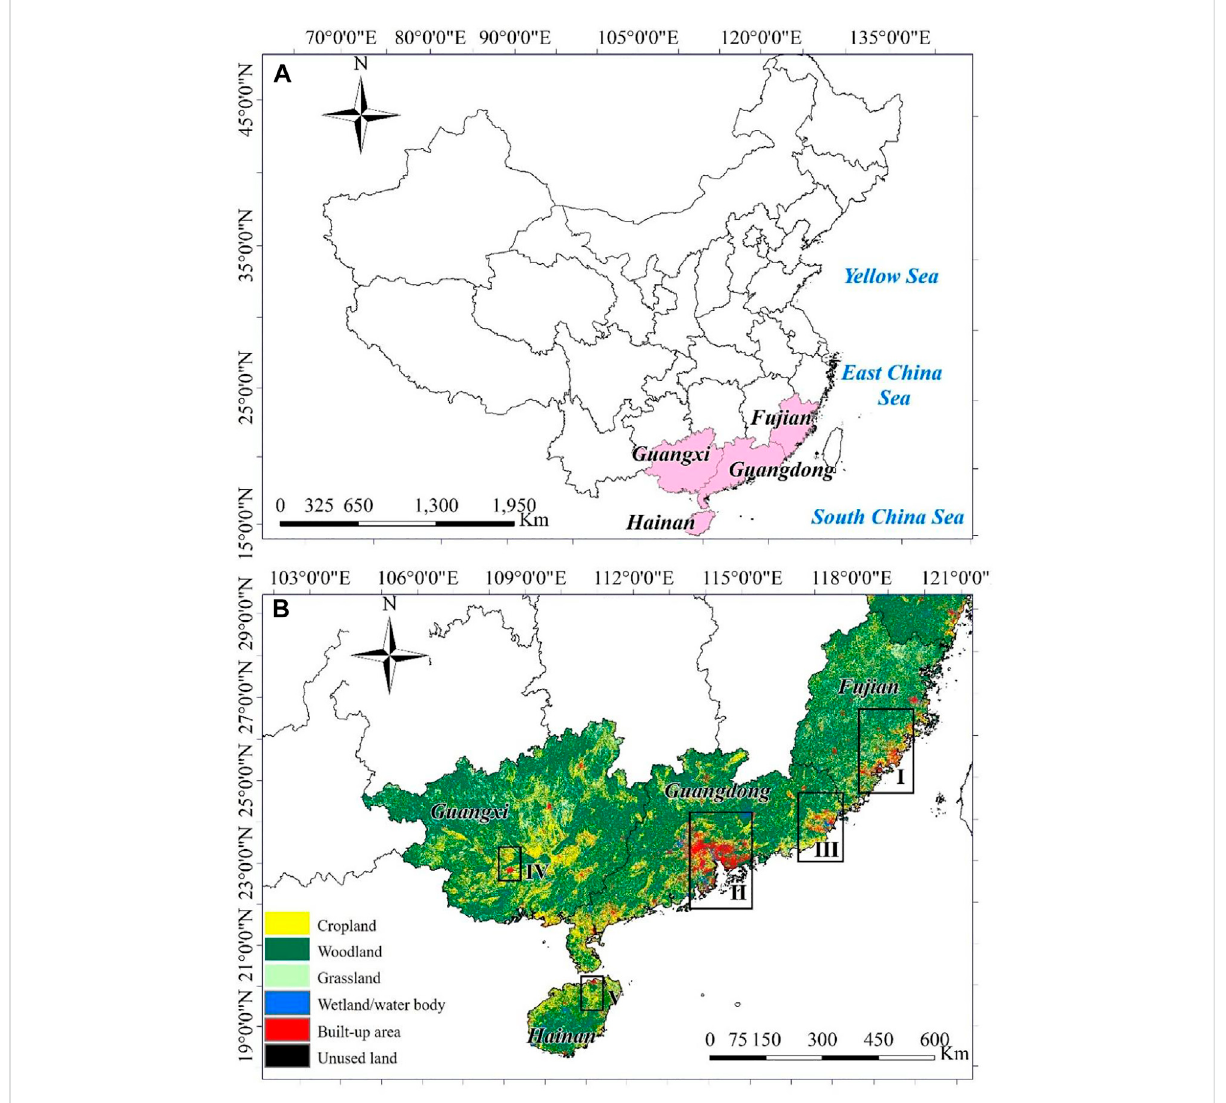
FIGURE 1 (A) Geographic situation of southeastern coastal areas in China and (B) LULC compositions in 2017. The fi ve hotspots experiencing rapid urban expansion are identi fi ed in (B) : (I) Fujian province coastal city cluster (i.e., Xiamen, Zhangzhou, and Quanzhou cities), (II) the Pearl River Delta